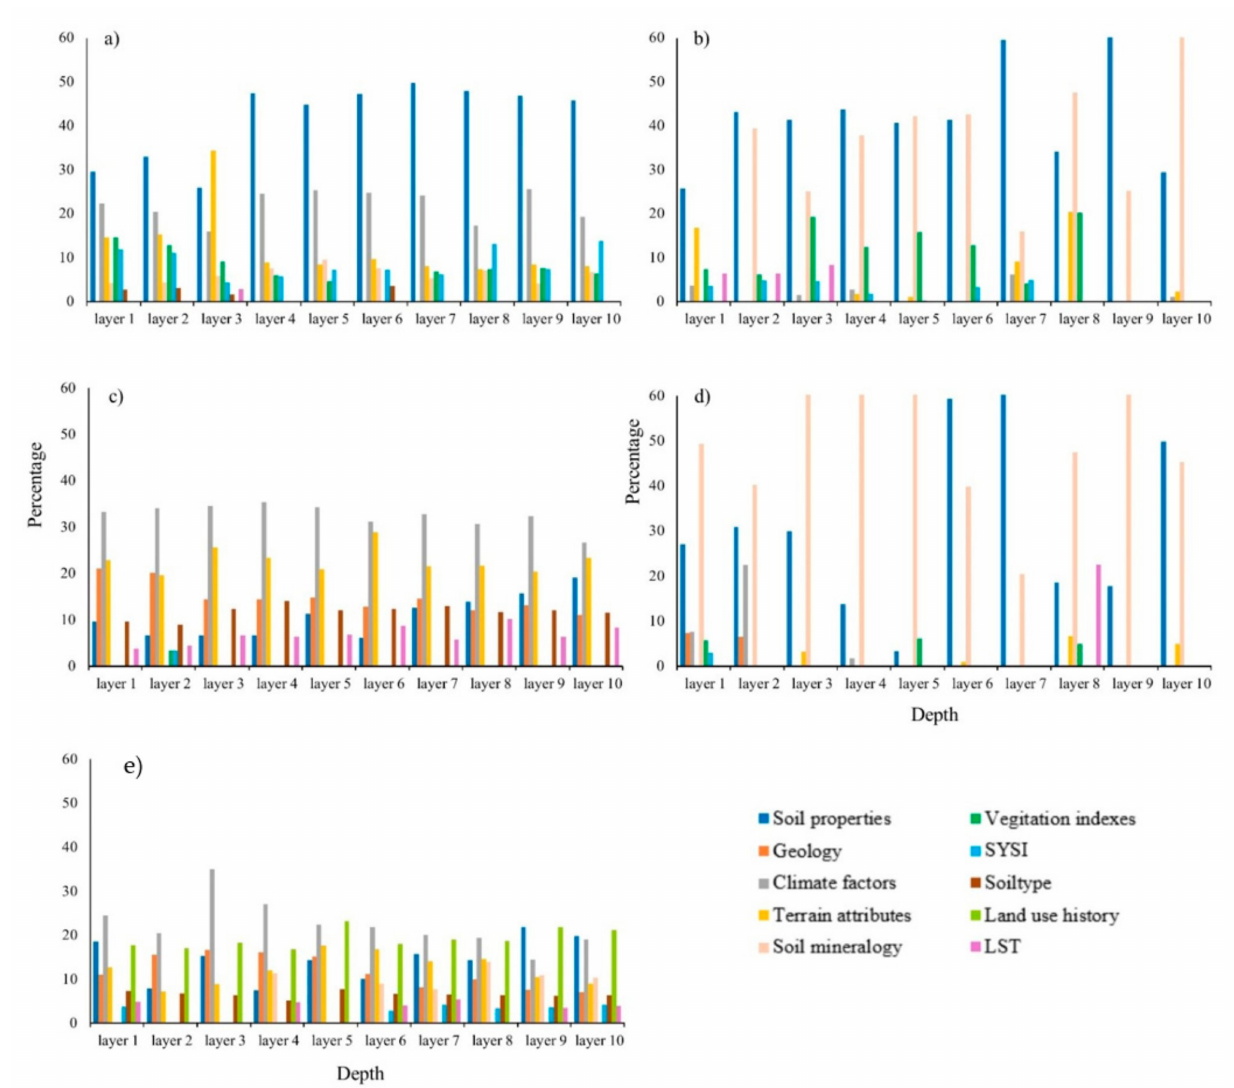
Figure 11. Comparing the importance (%) of all factors in ( a ) Ag = 100, ( b ) Pas = 100, ( c ) Ag > 50–Pas < 50 ( d ) Ag > 50–Fo < 50, ( e ) total samples for SOC stocks prediction in different